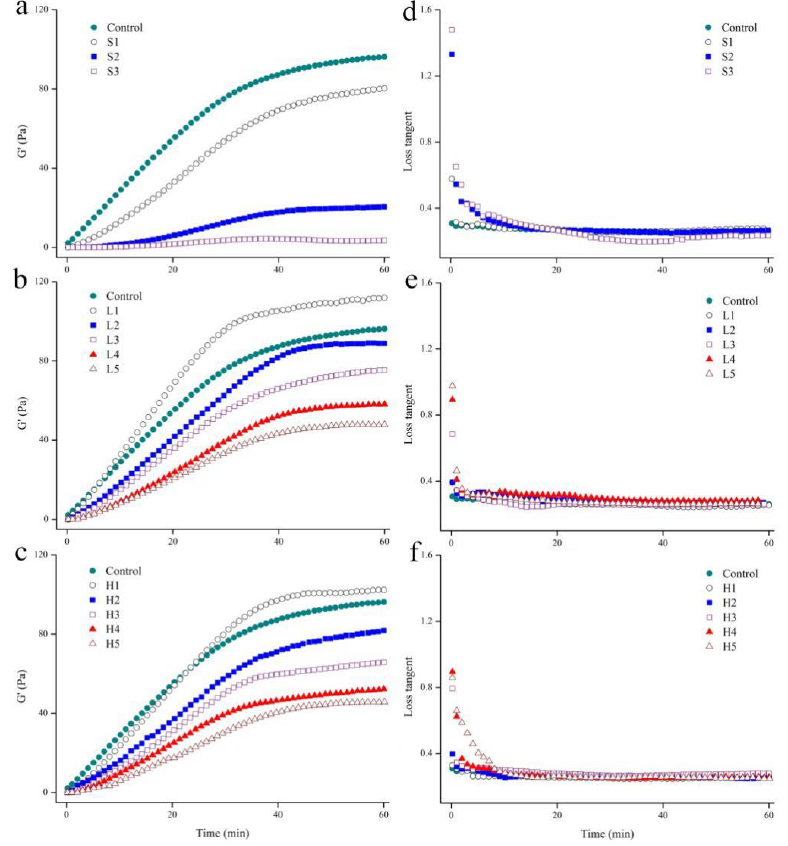
Figure 2. The changes in storage modulus (G’) ( a – c ) and loss tangent ( d – f ) during rennet induced gelation. Curves are representative runs. Table 1. The rheological parameters of mixtures during renneting.